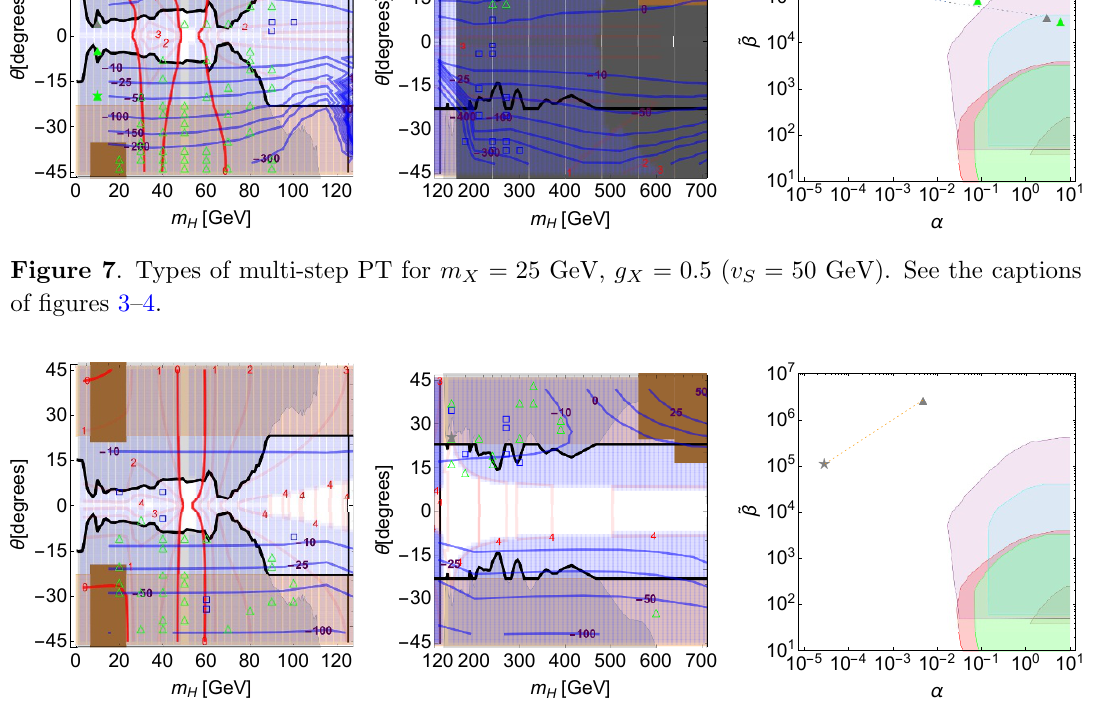
Figure 8 . Types of multi-step PT for m X = 25 GeV, g X = 0 . 125 ( v S = 200 GeV). See the captions of figures 3–4.